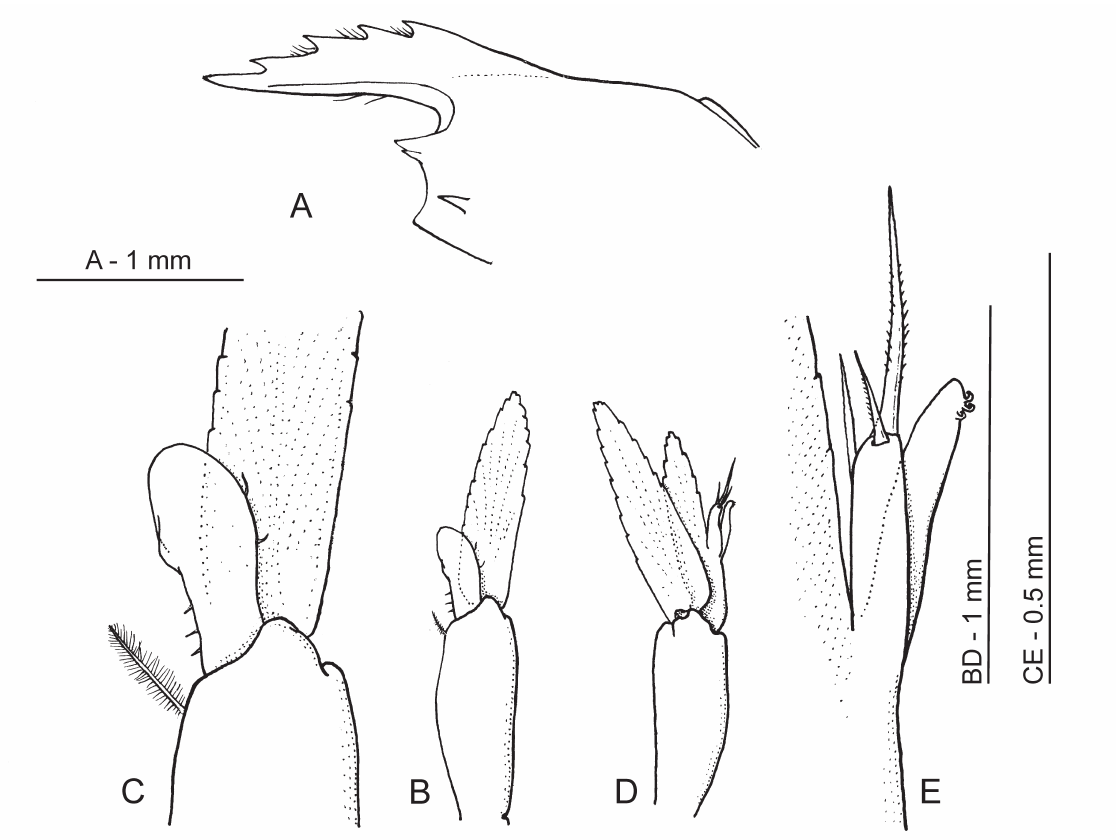
Fig. 5. Hamodactylus paraqabai sp. nov., ♂ (PoCL 1.1 mm, Lizard Is., Australia, MTQ-33218). A . Carapace and rostrum, lateral. B . First pleopod. C . Same as previous, endopod. D . Second pleopod. E . Same as previous, appendices interna and